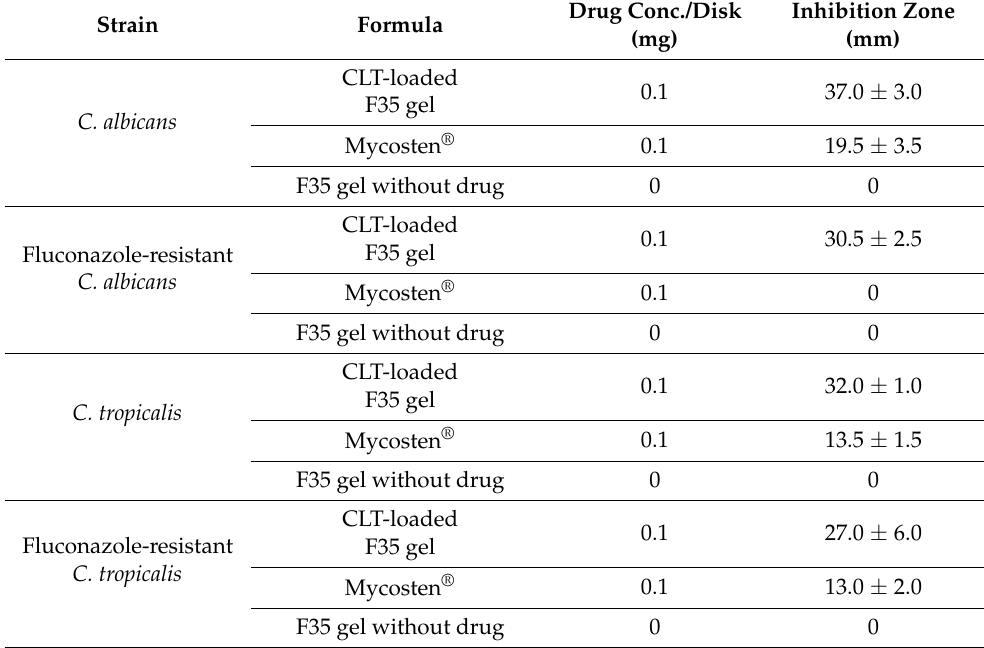
Each value represents the average of three independent